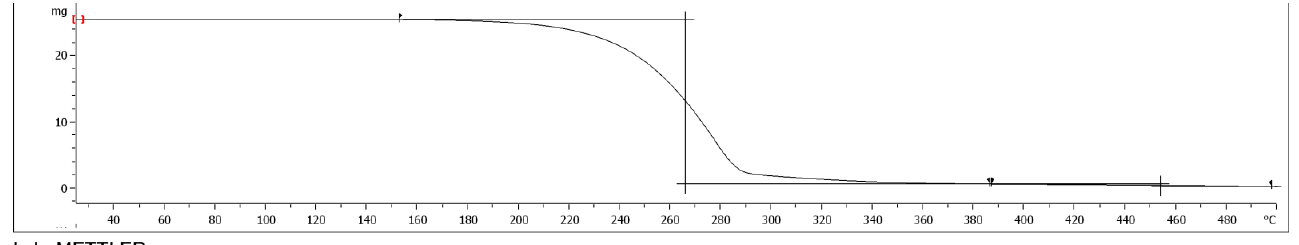
Figure 4. TGA curve of decyl butoxyethyl adipate.